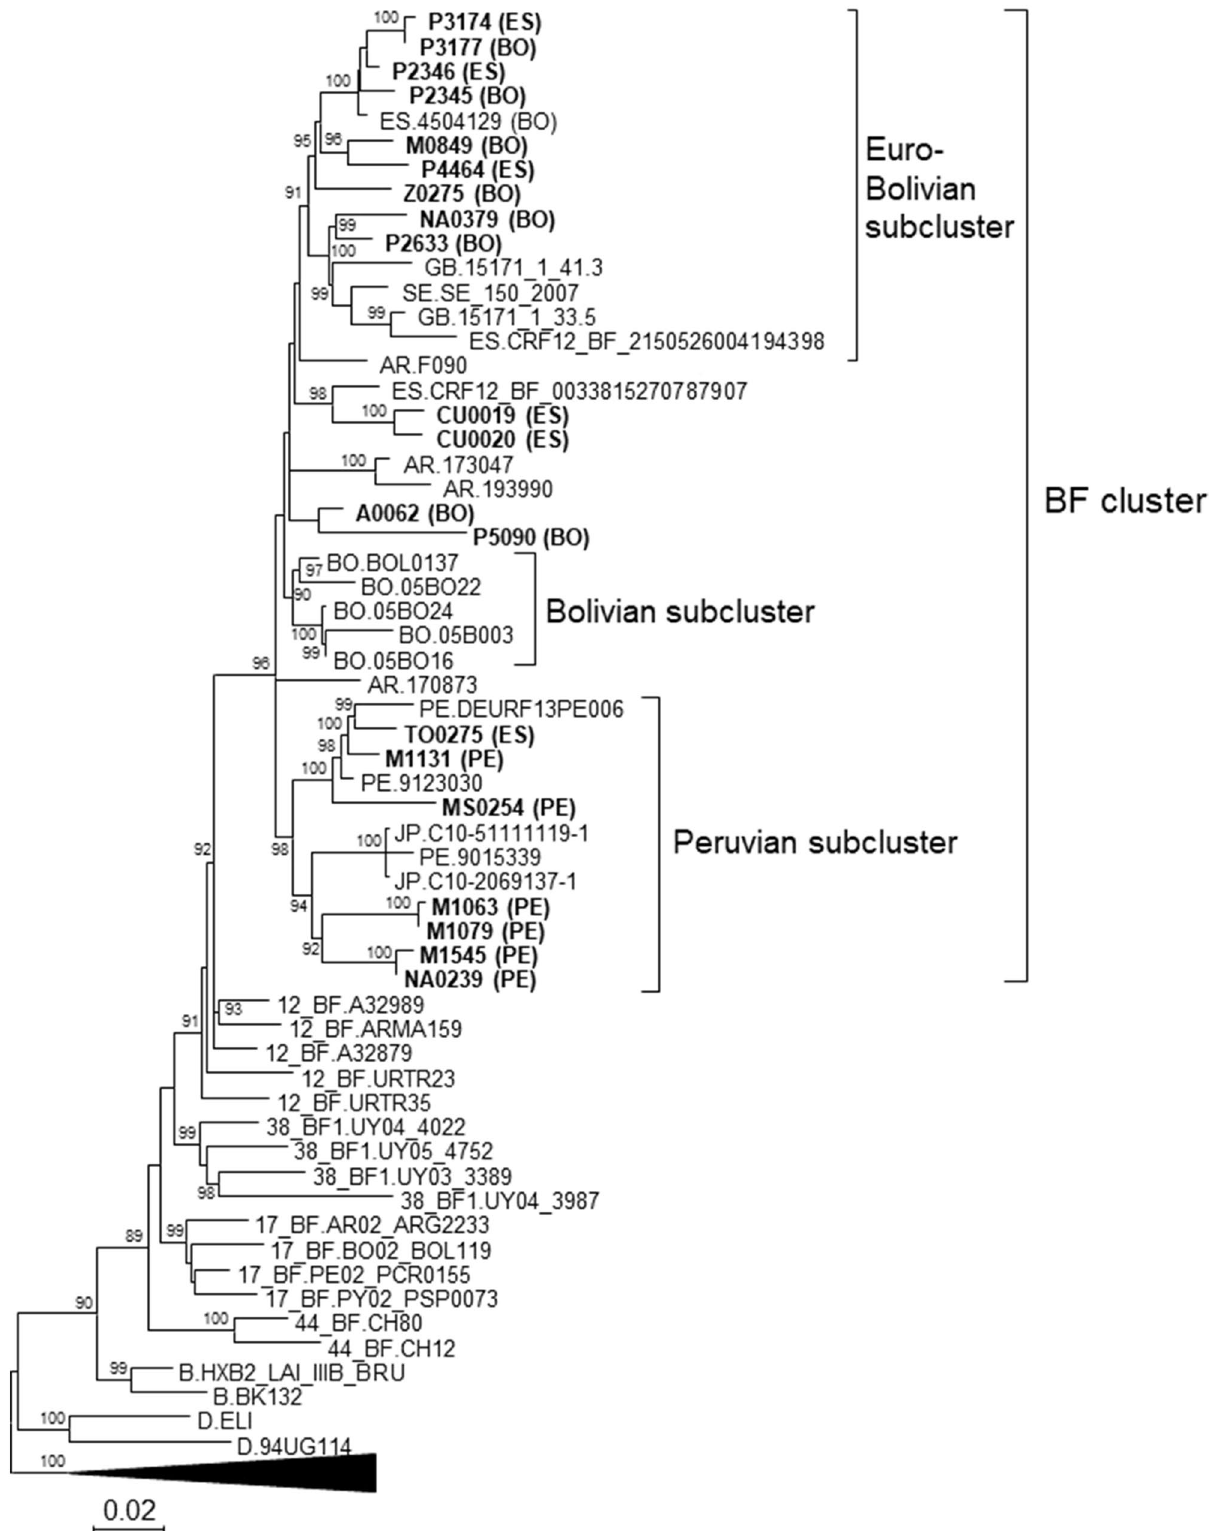
Figure 1. Maximum likelihood tree of Pr-RT sequences of BF cluster. Names of sequences obtained by us, all collected in Spain, are in bold type. Two-letter ISO code of country of origin of the individual, when known, is in parentheses after the virus name. In database sequences branching in the BF cluster, the country of sample collection is indicated before the virus name with the two-letter ISO country code. In reference sequences, subtype or CRF is indicated before the virus name. Branches corresponding to references of subtypes A, C, F, G, and H are compressed. Only bootstrap values ≥ 80% are